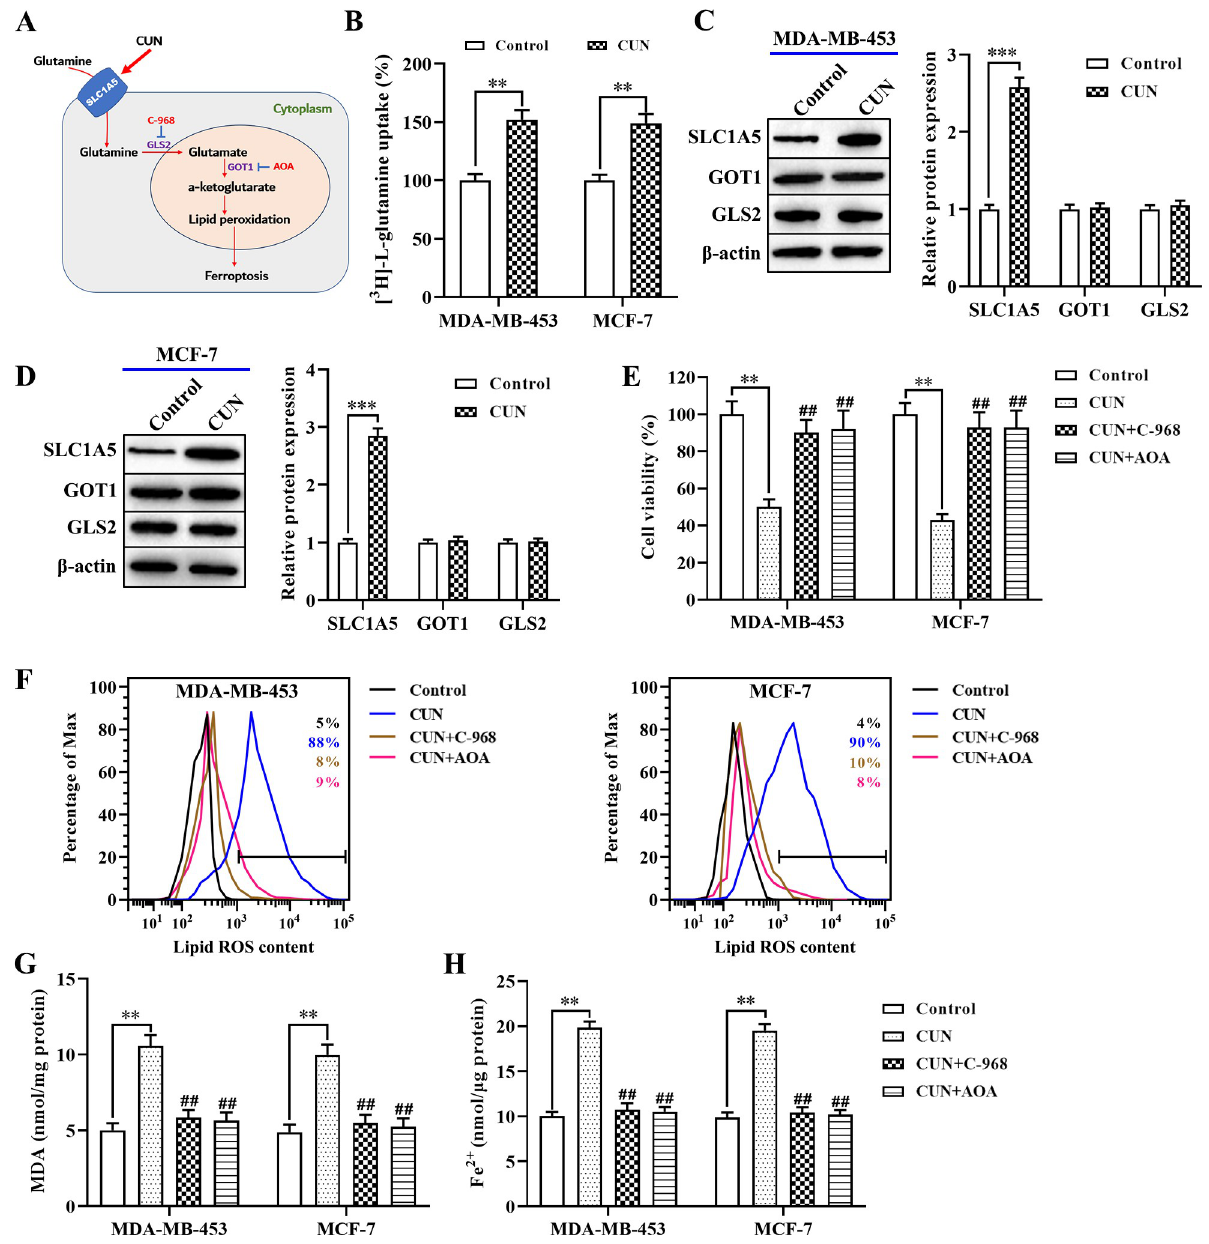
Fig 3. Suppression of glutamine uptake is essential for CUN-induced ferroptosis in BC. A: Schematic overview of the glutaminolysis pathway in ferroptosis; B: The [ 3 H]- L -glutamine uptake was determined using a liquid scintillation counter; C and D: Western blot analysis was performed to detect the protein levels of SLC1A5, GOT1, and GLS2 in both BC cell lines; E: The CCK-8 assay was used to examine cell viability; F: Flow cytometry was employed using C11-BODIPY to detect the levels of lipid ROS in cells treated with curcumin or erastin; G: The MDA accumulation was examined by a lipid peroxidation assay kit; H: The intracellular Fe 2+ levels were measured in both BC cell lines by an iron assay kit. Each data point is expressed as the mean ± SEM of 3–5 independent tests. �� P < 0.01, ��� P < 0.001. ## P < 0.01, compared with the curcumin treatment alone group. CUN, curcumin; BC, breast cancer; SLC1A5, solute carrier family 1 member 5; GOT1, aspartate aminotransferase; GLS2, glutaminase 2; CCK-8, cell counting kit-8; ROS, reactive oxygen species; MDA, malondialdehyde; SEM, standard error of the